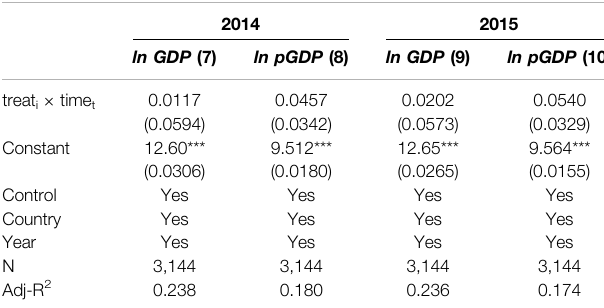
TABLE 4 | Counterfactual hypothesis